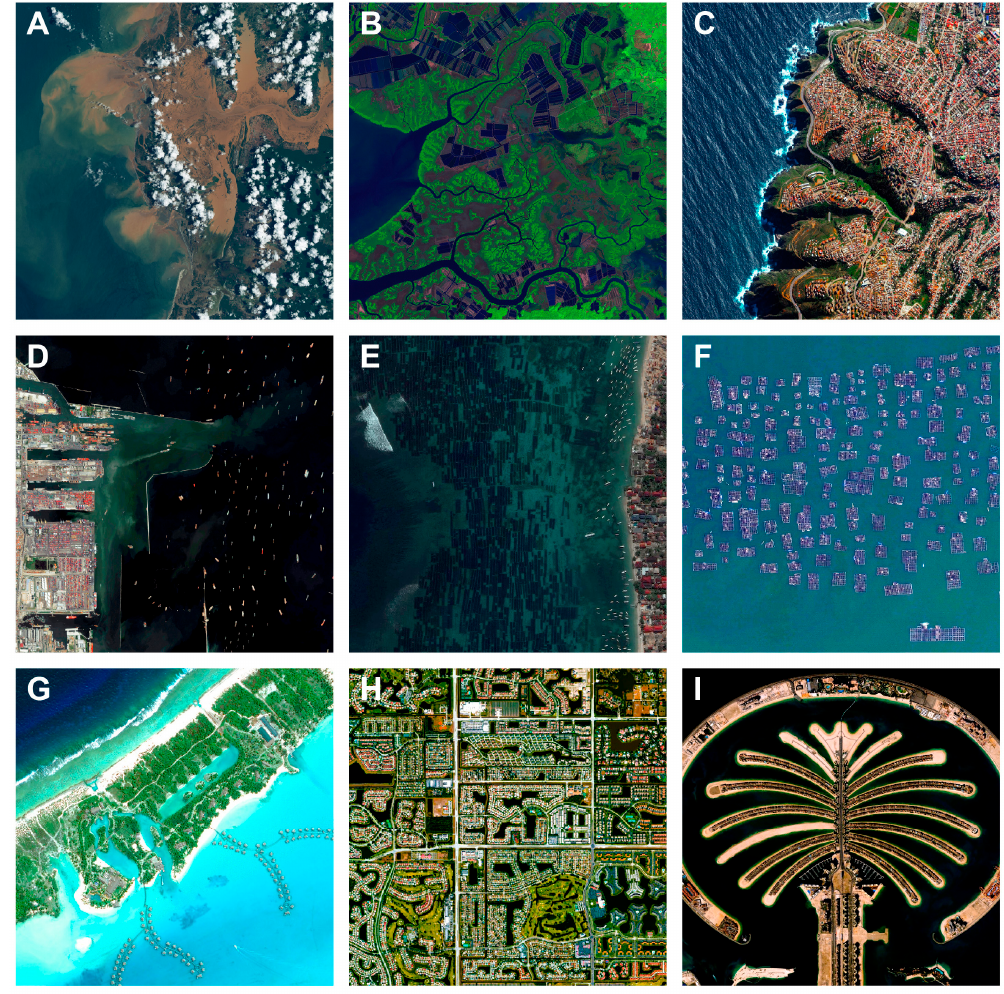
Figure 1. Examples of human–coastal environments, or aspects of potential coastal anthromes: ( A ) Suspended sediment at the mouth of the flooded Tsiribihina River, Madagascar (19°42'01" S, 44°33'00" E); ( B ) Mangroves converted to shrimp ponds on the west coast of Honduras (13°04'04" N, 87°22'00" W); ( C ) Cliff-top development above Valparaíso, Chile (33°01'45" S, 71°38'47" W); ( D ) Tankers and port complex at Tanjung Priok, Jakarta, Indonesia (6°06'14" S, 106°53'11"E); (E ) Seaweed farming at Nusa Lembongan, Indonesia (08°41'50" S, 115°26'40" E); ( F ) Fish farms in the Taiwan Strait (24°48'40" N, 119°55'42" E); ( G ) Resort on Motu Tehotu, French Polynesia (16°28'19" S, 151°42'26" W); ( H ) Housing subdivisions and canals in Boca Raton, Florida, USA (26°22'07" N, 80°06'00" W); and ( I ) The Palm Jumeirah, a made-ground development in Dubai, UAE (25°06'53" N, 55°08'16" E). (Images: ( A , B ) via NASA Earth Observatory; ( C – I ) via Daily Overview/DigitalGlobe.)